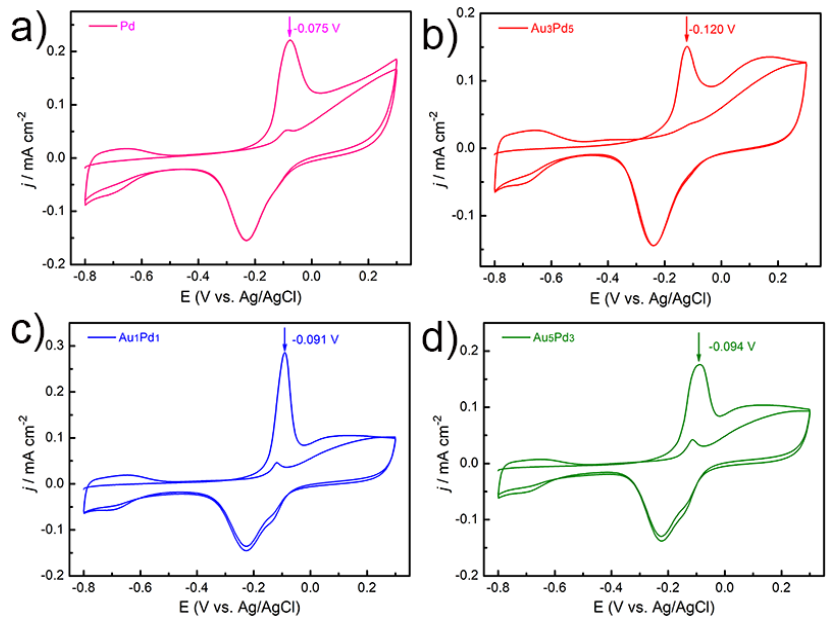
Figure 7. CO stripping curves of various catalysts with ( a ) Pd, ( b ) Au3@Pd5, ( c ) Au1@Pd1 and ( d ) Au3@Pd3 DNPs in 0.1 M KOH at a scan rate of 20